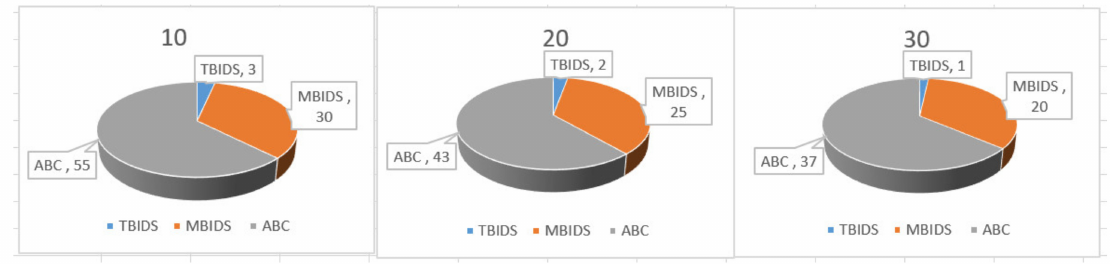
Figure 19. Packet loss for large-scale networks, 8000 sensor nodes, with 10, 20, and 30 sink